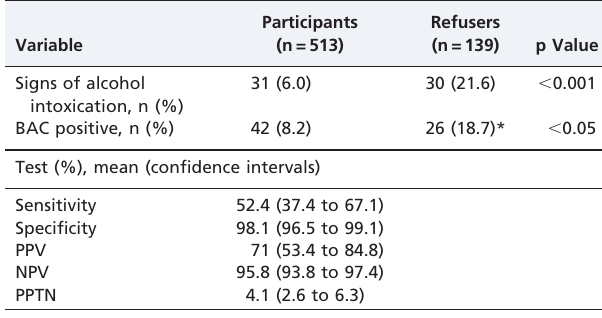
Table 1 - Alcohol